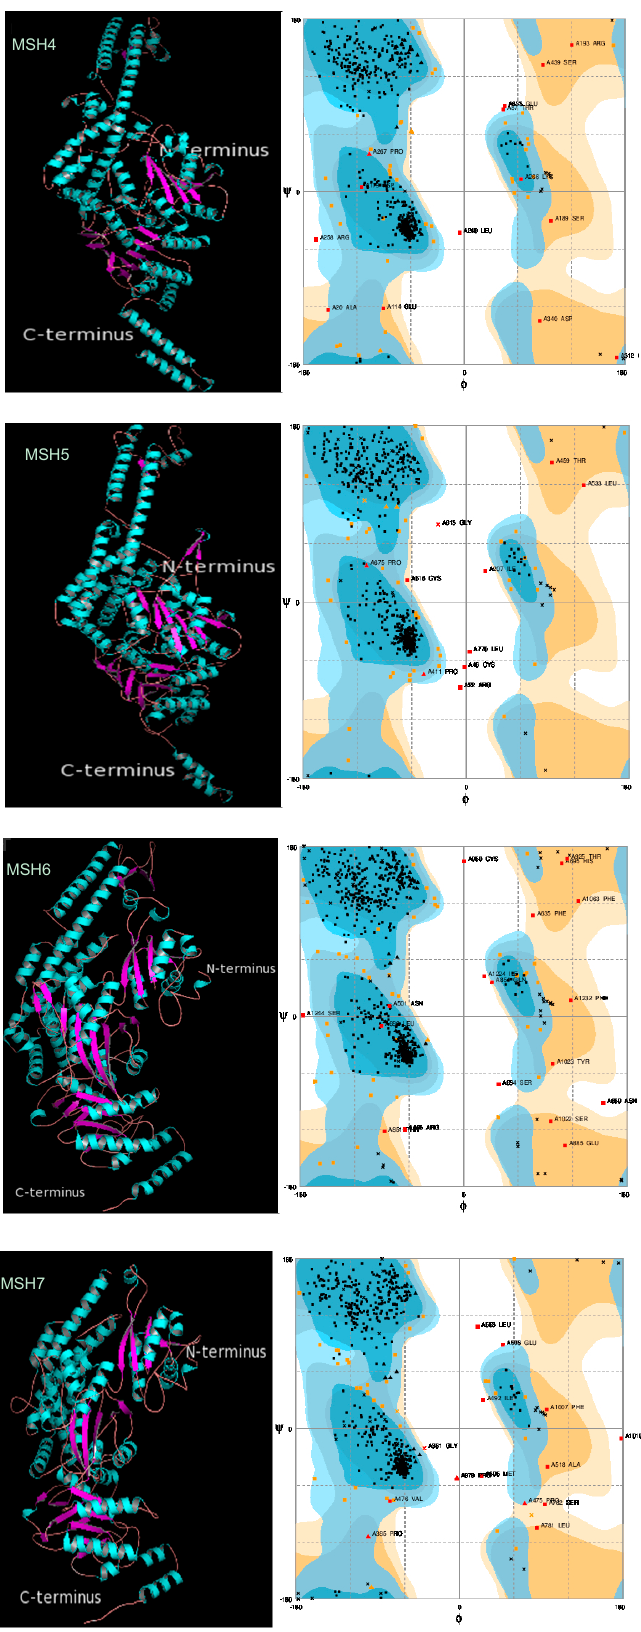
Figure 2. MSH1-MSH7 proteins’ 3D structure prediction visualized by PyMOL (left) and validated by Ramachandran plot (right). N-terminus and C-terminus are